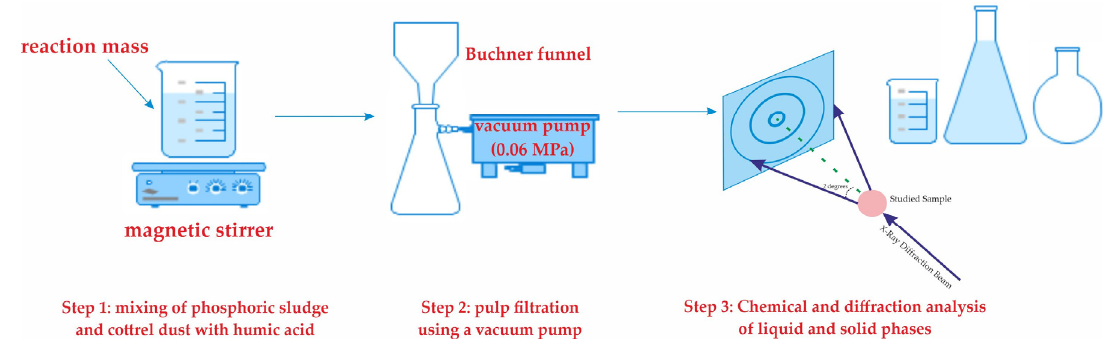
Figure 7. Experimental setup and sequence of experiment execution.